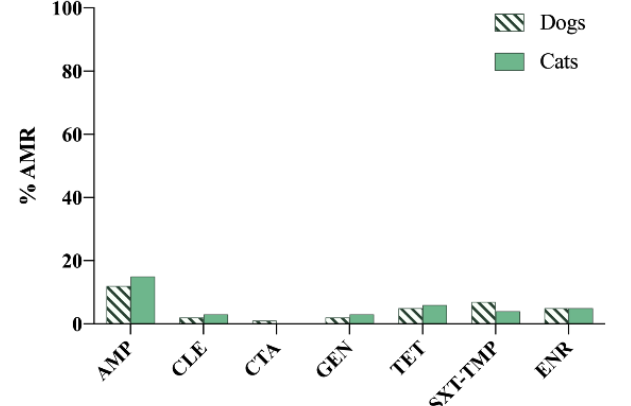
Figure 8. Antimicrobial resistance (AMR) prevalence in Escherichia coli isolated from dogs and cats in Sweden. AMP: ampicillin; CLE: cephalexin; CTA: cefotaxime; GEN: gentamicin; TET: tetracy- cline; SXT-TMP: sulfamethoxazole – trimethoprim; ENR: enrofloxacin.